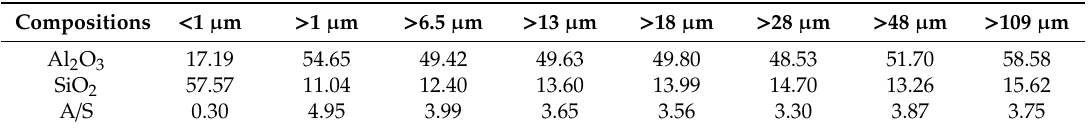
Table 4. Alumina and silica contents of BCFA after water leaching and wet screening with different sieve sizes (wt.%).